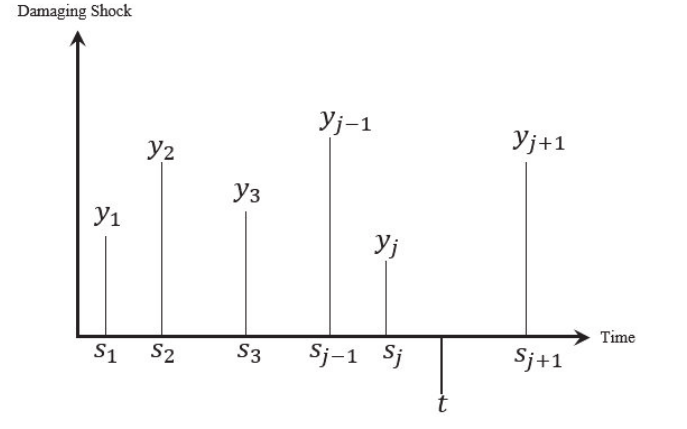
Fig. 1. Shock structures and the amount of